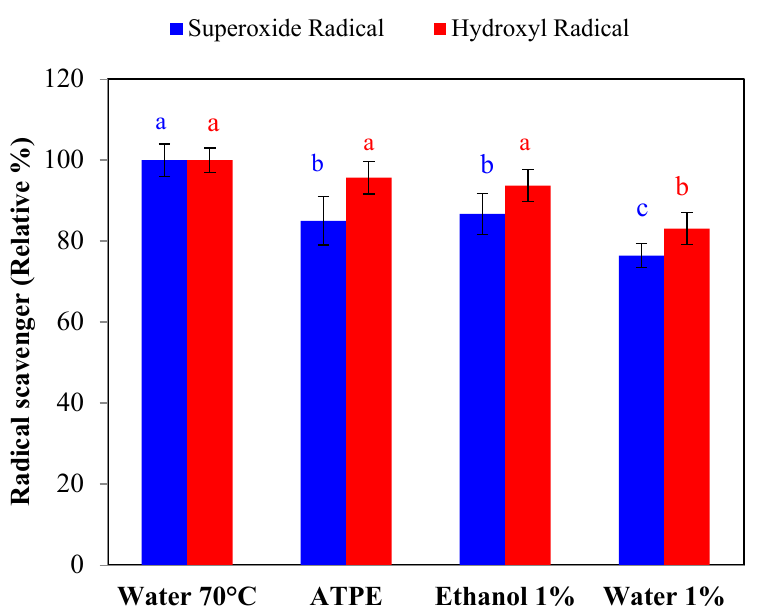
Figure 2. Radical-scavenging capacity of H. macrocarpa extracts. Bars with different letters (a to c) at the same color, are significantly different ( p < 0.05).